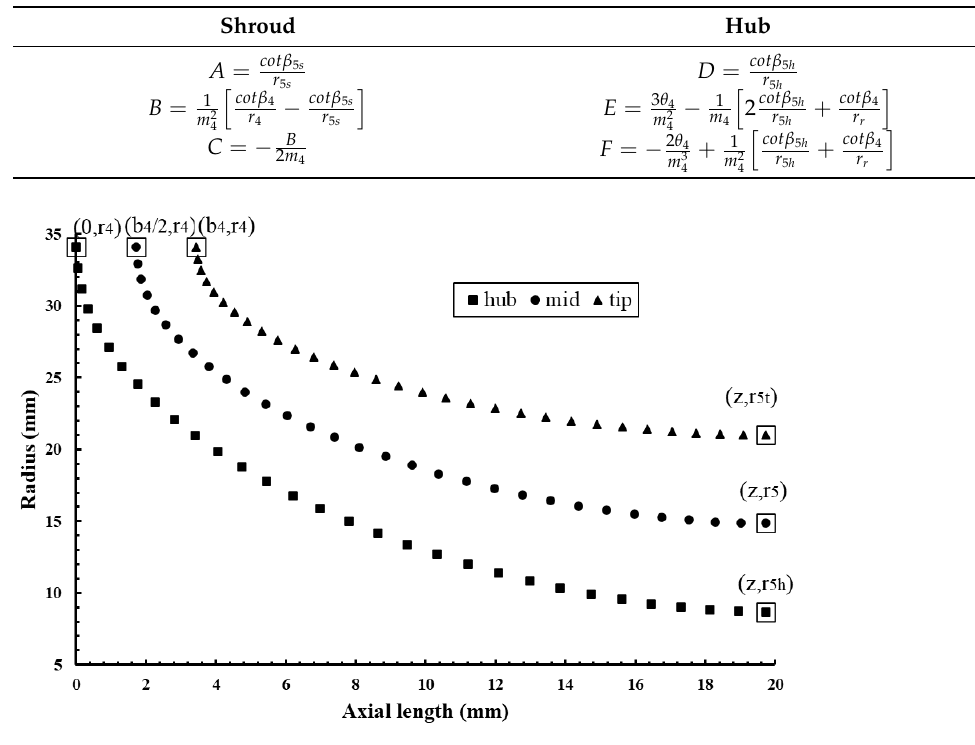
Figure 7. Meridional profiles of the turbine blade.